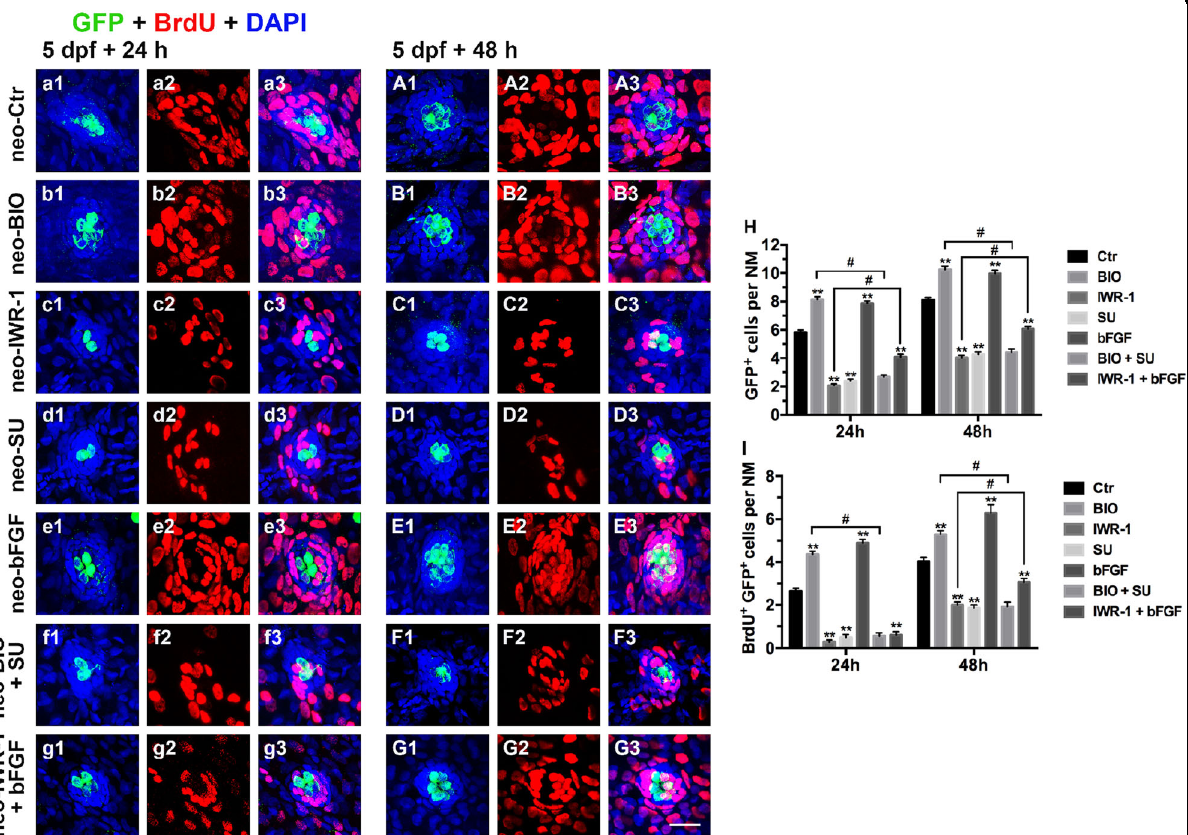
Fig. 9 Effects of exogenous regulation of the Wnt and FGF pathways on HC regeneration at 24 hpa and 48 hpa after neomycin injury. a1 – G3 : Regenerating cells labeled with BrdU (red) and HCs labeled with GFP (green). a1 – a3 : 24 hpa after neomycin damage; A1 – A3 : 48 hpa after neomycin damage; b1 – b3 : 24 hpa after addition of BIO; B1 – B3 : 48 hpa after addition of BIO; c1 – c3 : 24 hpa after addition of IWR-1; C1 – C3 : 48 hpa after addition of IWR-1; d1 – d3 : 24 hpa after addition of SU5402; D1 – D3 : 48 hpa after addition of SU5402; e1 – e3 : 24 hpa after addition of bFGF; E1 – E3 : 48 hpa after addition of bFGF; f1 – f3 : 24 hpa after addition of BIO + SU5402; F1 – F3 : 48 hpa after addition of BIO + SU5402; g1 – g3 : 24 hpa after